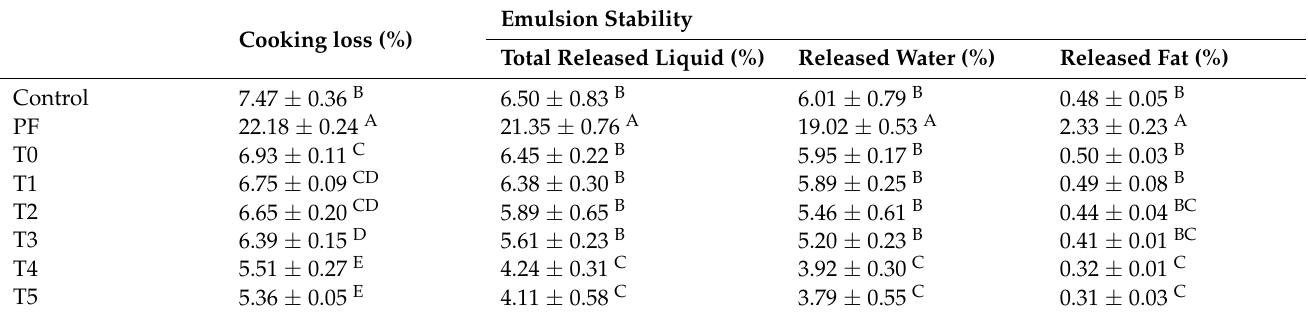
Table 5. Cooking loss and emulsion stability of phosphate-containing frankfurters or phosphate-free frankfurters added with the combination of L-Arg and